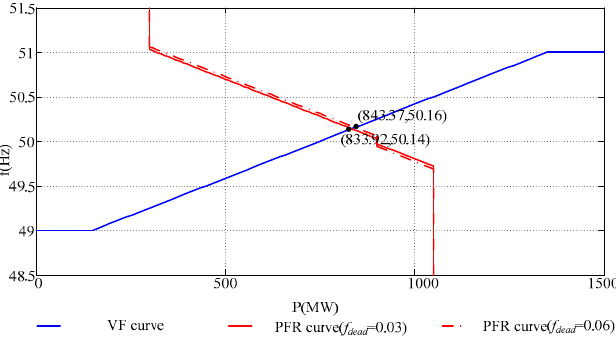
Figure 10. VF curve and PFR curves (fdead = 0.03 and fdead = 0.06).